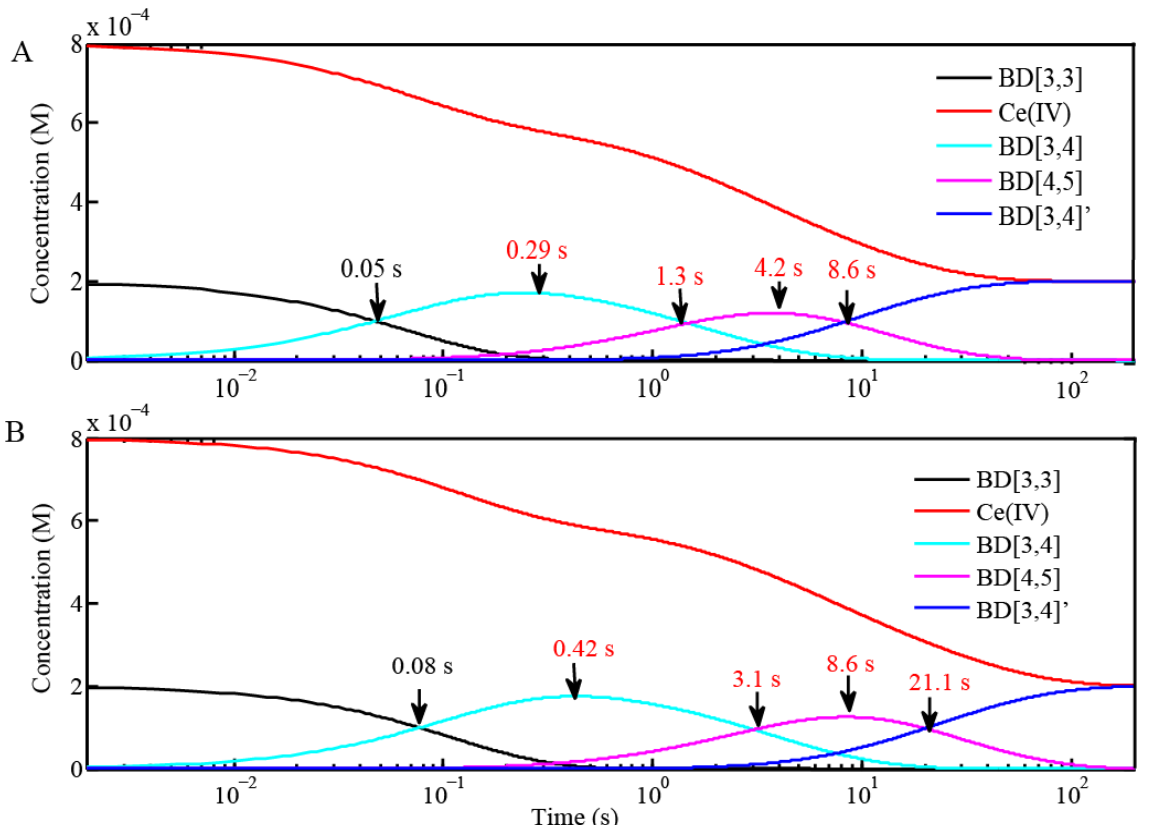
Figure 4. Kinetic modeling of the reaction of 0.1 mM BD[3,3] with 4 equiv of Ce(IV) at pH 1 in ( A ) H O and ( B ) D O. Concentration profiles of BD[3,3], BD[3,4], 2 2